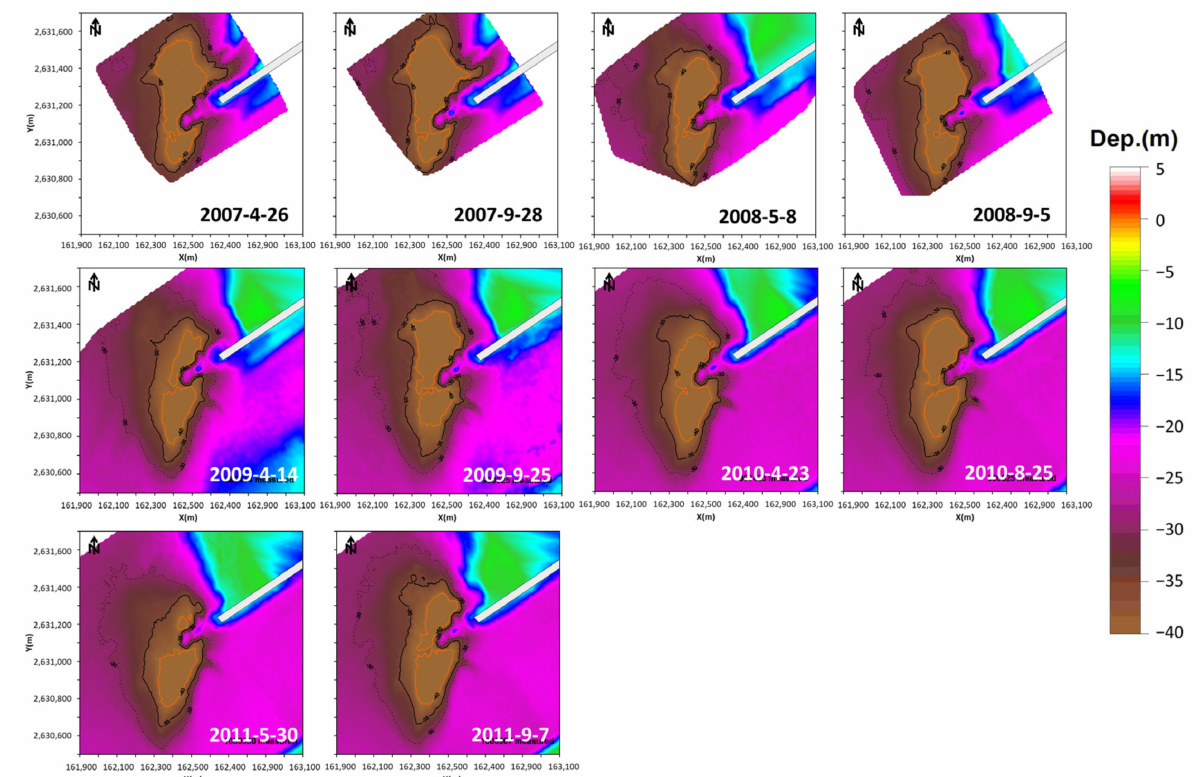
Figure 10. High-resolution topographic data near the West